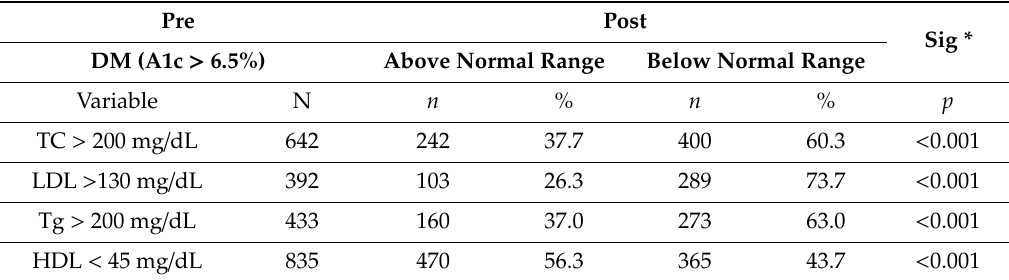
Table 2. Shift in those with high lipid levels after yoga in diabetes patients. Pre Post Sig * DM (A1c > 6.5%) Above Normal Range Below Normal Range Variable N n % n % p TC > 200 mg / dL 642 242 37.7 400 60.3 < 0.001 LDL > 130 mg / dL 392 103 26.3 289 73.7 < 0.001 Tg > 200 mg / dL 433 160 37.0 273 63.0 < 0.001 HDL < 45 mg / dL 835 470 56.3 365 43.7 < 0.001 * McNemar’s test: p ≤